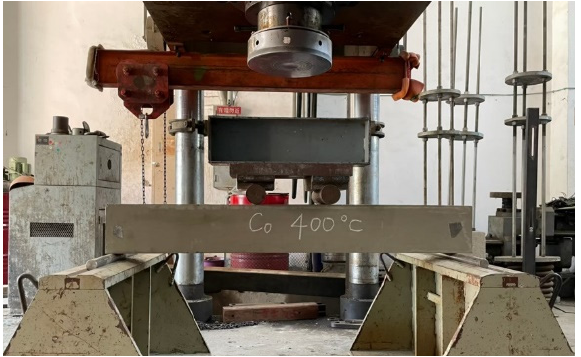
Figure 4. The general flexural test setup for the beam specimens.